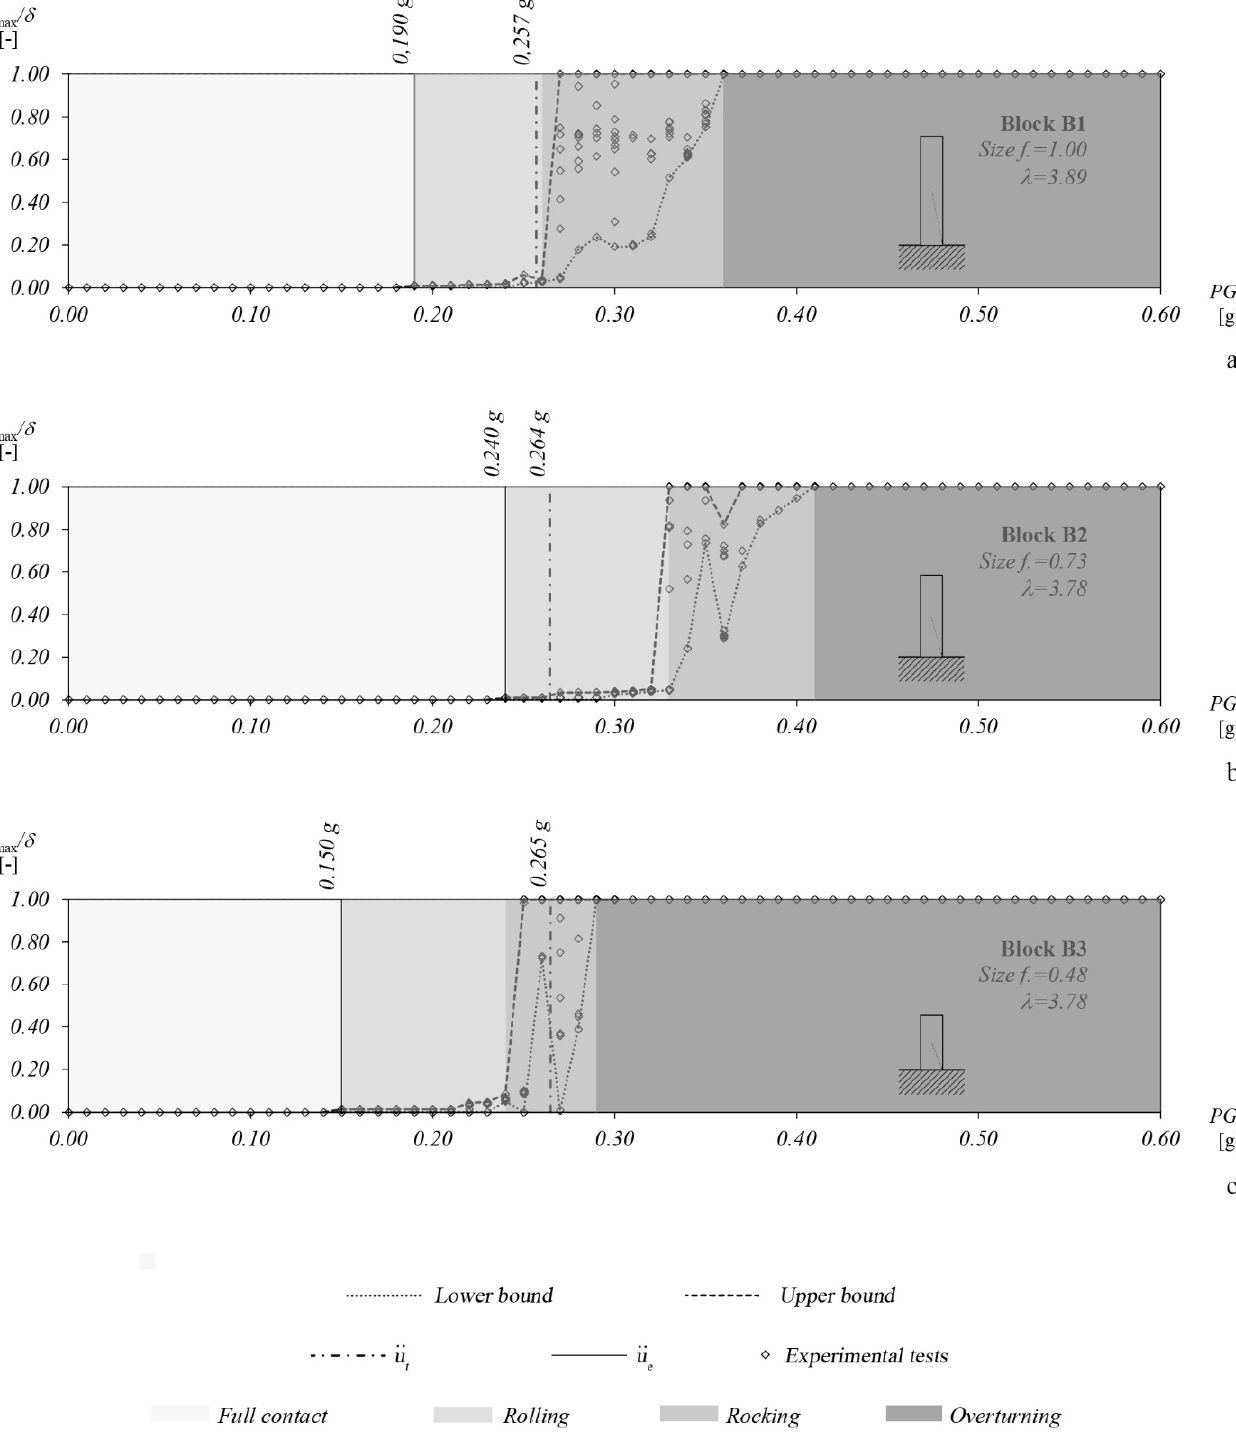
Figure 15. Response variability for blocks B: ( a ) B1; ( b ) B2; ( c ) B3. As shown by the graphs, the experimental PGA at rocking outset is in all the considered cases lower than the theoretical one, mainly due to the imperfections in the contact surface of the blocks. In addition, it should be mentioned that asymmetries or zones with different density material may affect the